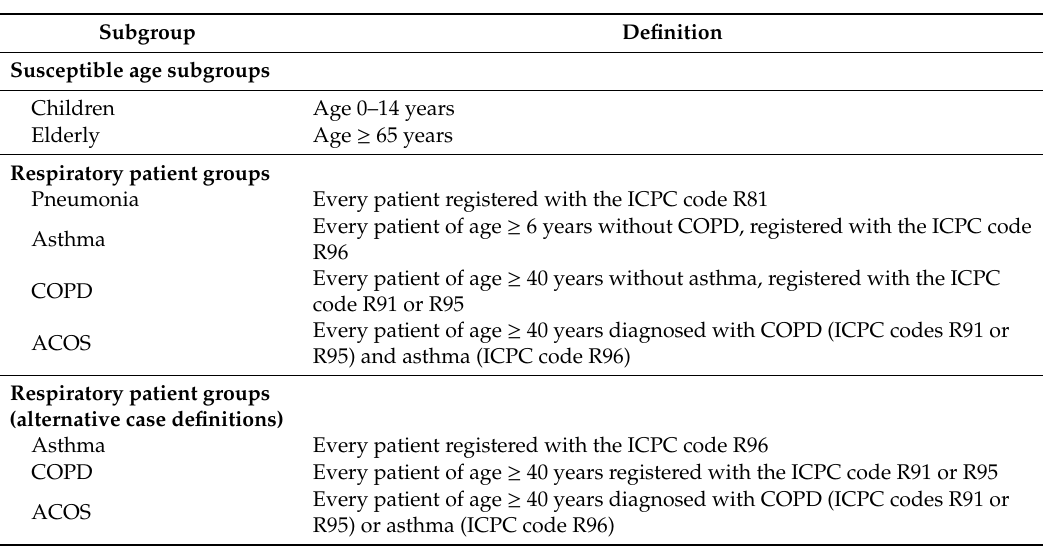
Table A2. Definition of the di ff erent patient subgroups in the present analyses.